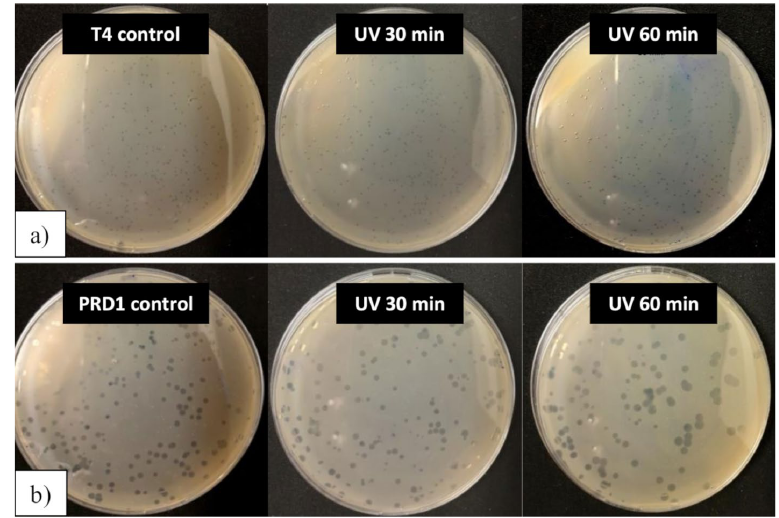
Fig. 6. Formation of plaques by treated bacteriophages T4: a) and PRD1 b). Photocatalytic treatment was performed using visible light and metallic Zn rich ZnO thin film.